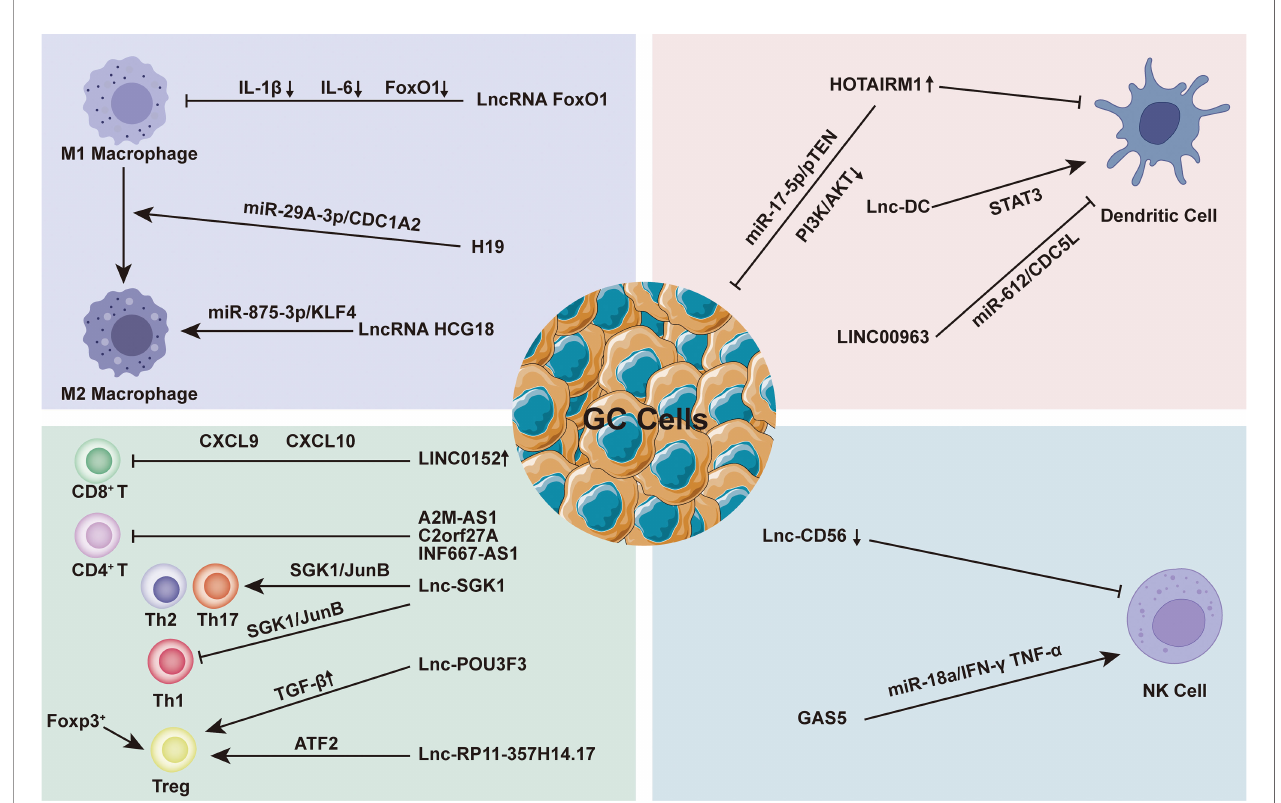
FIGURE 2 | Regulation of Long non-coding RNA (lncRNAs) on immune cells in the immune microenvironment of gastric cancer (TIME). At the microenvironmental level, lncRNAs are involved in mediating and controlling various immune-cancer cell interactions. Abnormal anti-tumor immune cells [such as macrophages, dendritic cells (DC), natural killer cells (NK), and T cells and regulatory T cells (Tregs) induce the formation of immunosuppressive microenvironments, thus contributing to tumor cell